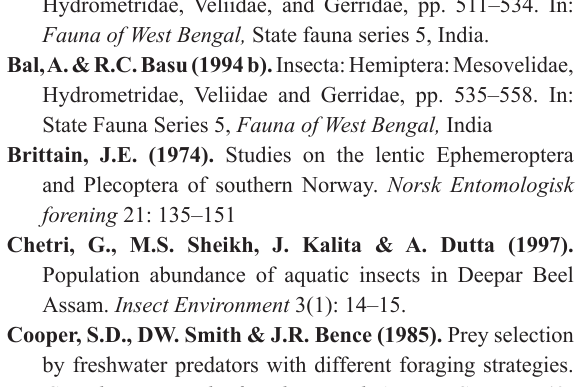
* = Correlation is significant at the P<0.05 level (2-tailed); ** = Correlation is significant at the P<0.01level (2-tailed) AT - Air temperature; WT - Water temperature; DO - Dissolved oxygen; EC - Electrical conductivity; TDS - Total dissolved solid; TSS - Total suspended solid; TR -